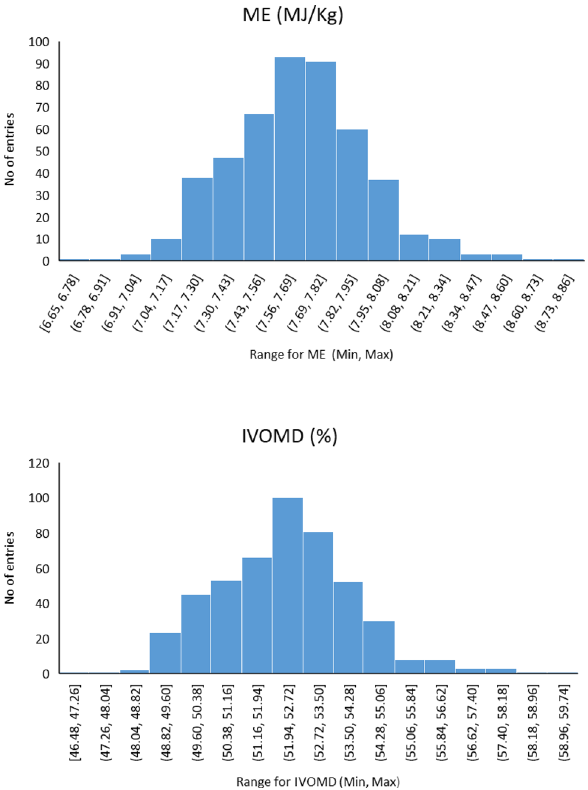
Figure 1. Frequency distribution for the two stover quality traits in association mapping panel and the training set.